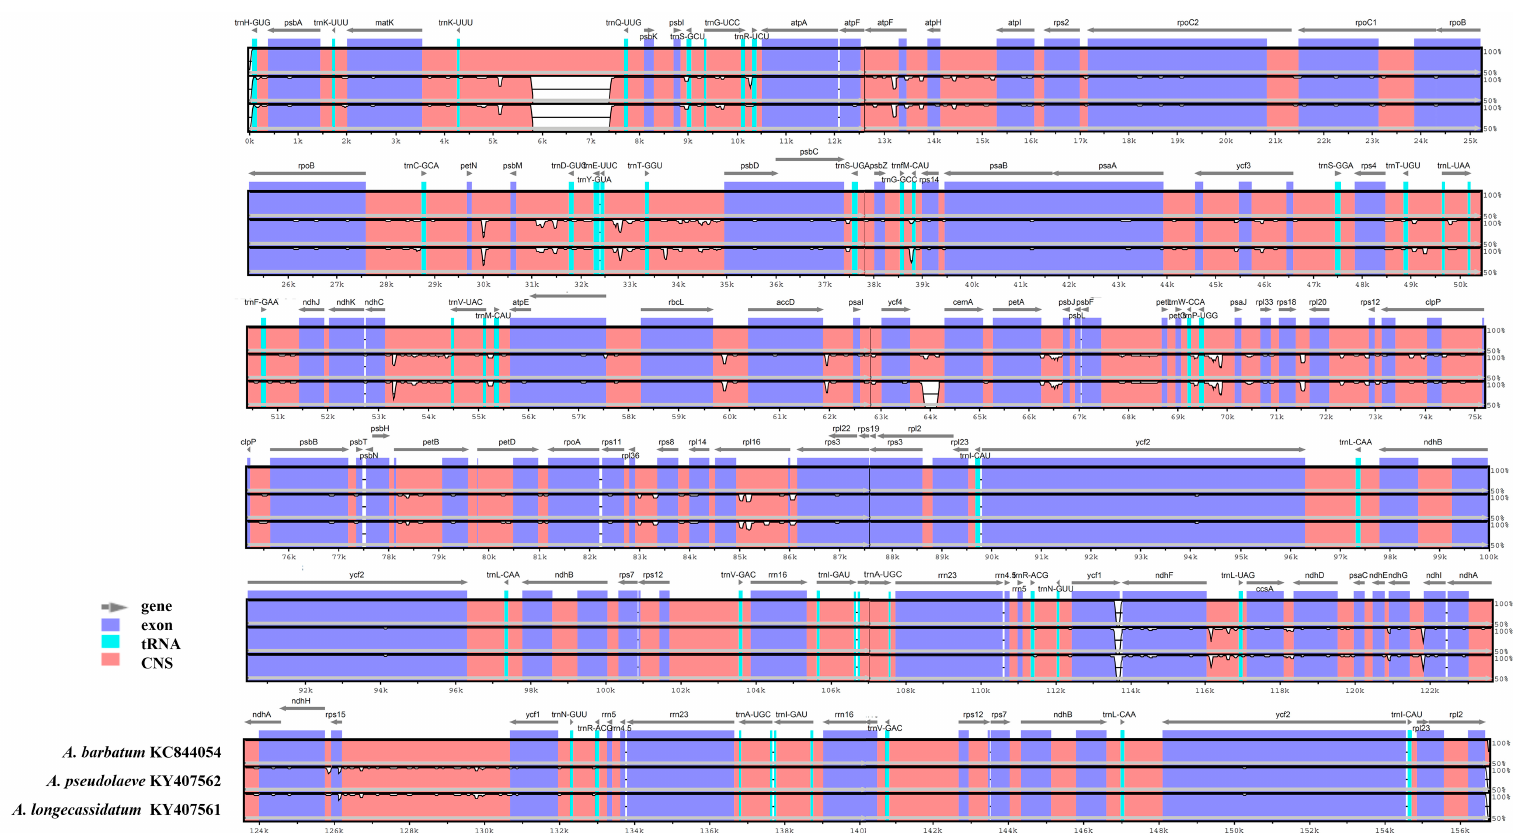
Figure 4. Comparison of A. pseudolaeve Nakai, A. longecassidatum Nakai and Aconitum barbatum Patrin ex Pers. chloroplast (CP) genomes using mVISTA. Complete CP genomes of A. pseudolaeve and A. longecassidatum were compared with A. barbatum as a reference. Blue block: conserved gene; sky-blue block: tRNA and rRNA; red block: intergenic region. White peaks are sequence variation regions between A. barbatum and A. pseudolaeve, and A. barbatum and A. longecassidatum . CP: chloroplast; tRNA; transfer RNA; CNS: conserved non-coding sequence.